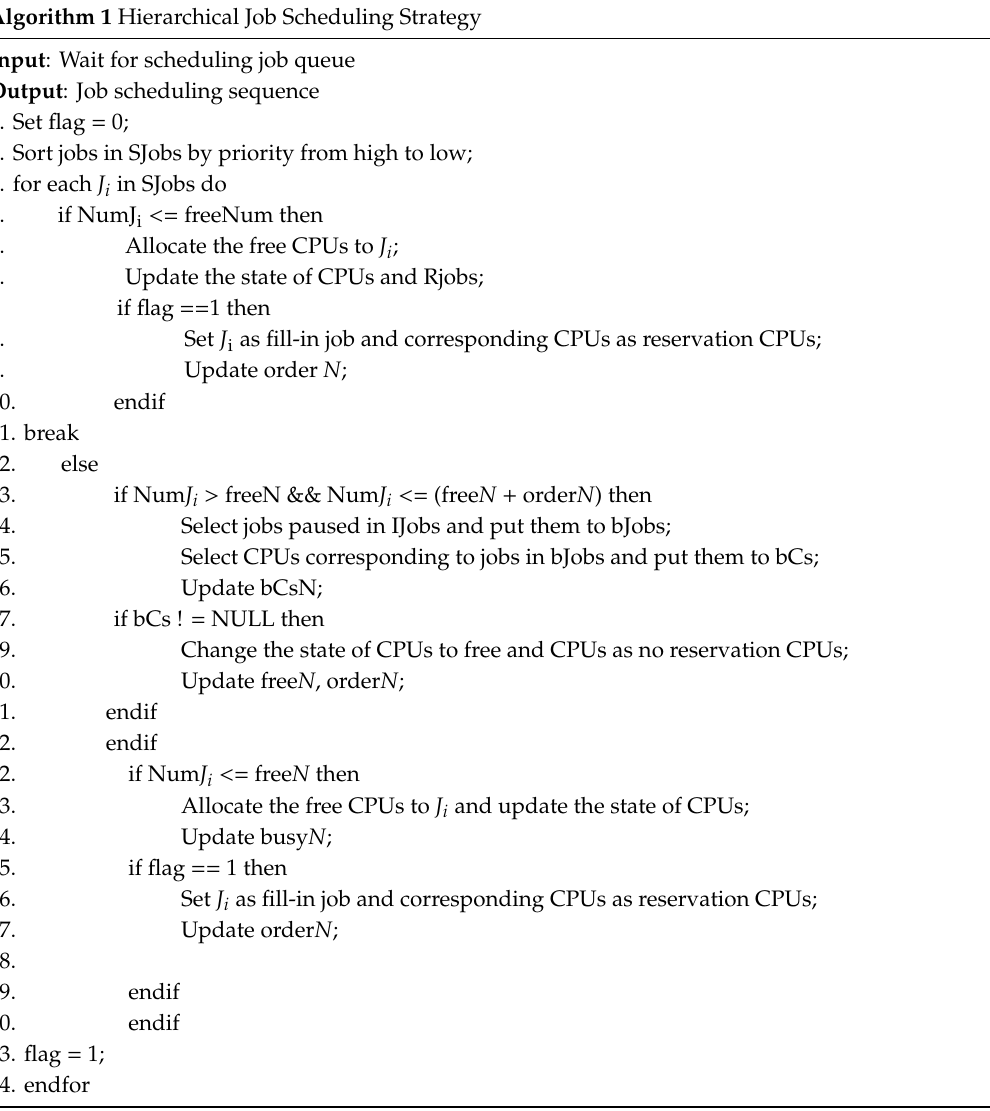
Algorithm 1 Hierarchical Job Scheduling